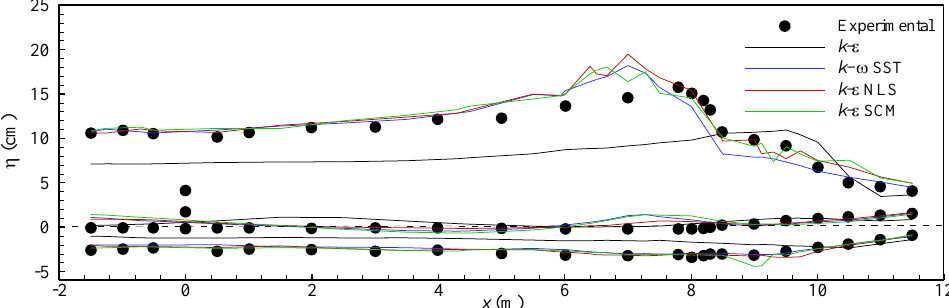
Figure 10. Maximum and minimum wave height envelopes and mean water level in the plunging case by using the k- ε , k- ω SST, k- ε NLS and k- ε SCM turbulence models.